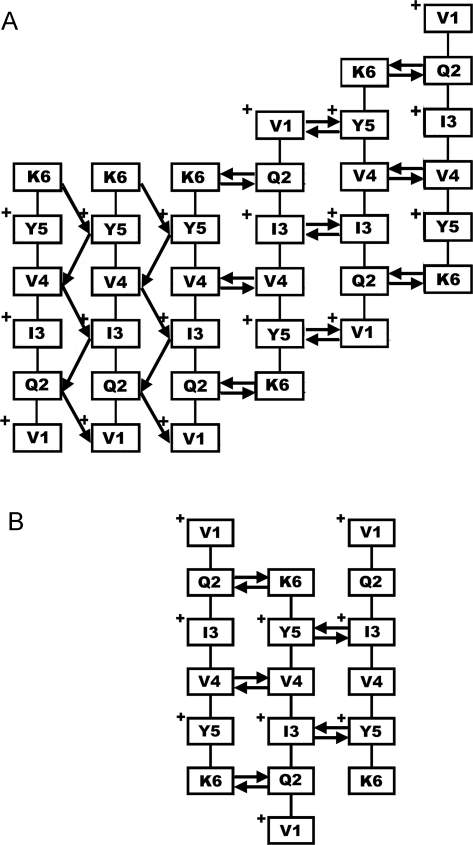
Illustration of parallel and anti-parallel arrangements.(a) Hydrogen bond pattern and strand alignment for the largest of the two β-sheets in Figure 3e. A “+” sign indicates that the side-chain is pointing outwards. (b) Illustration of an antiparallel off-register arrangement leading to a zig-zag pattern. Note that, despite the apparent symmetry about strand two, the number of hydrogen bonds between strands two and three is not the same as that between strands one and two. The arrows indicate hydrogen bonds, and point from the donor to the acceptor.